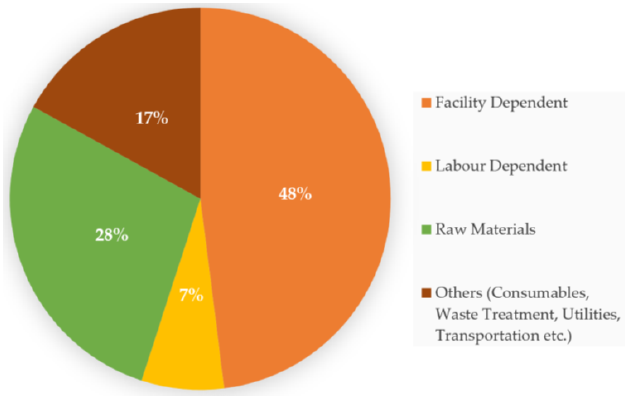
Figure 1. Breakdown of annual operating cost of a typical enzyme production plant [2].